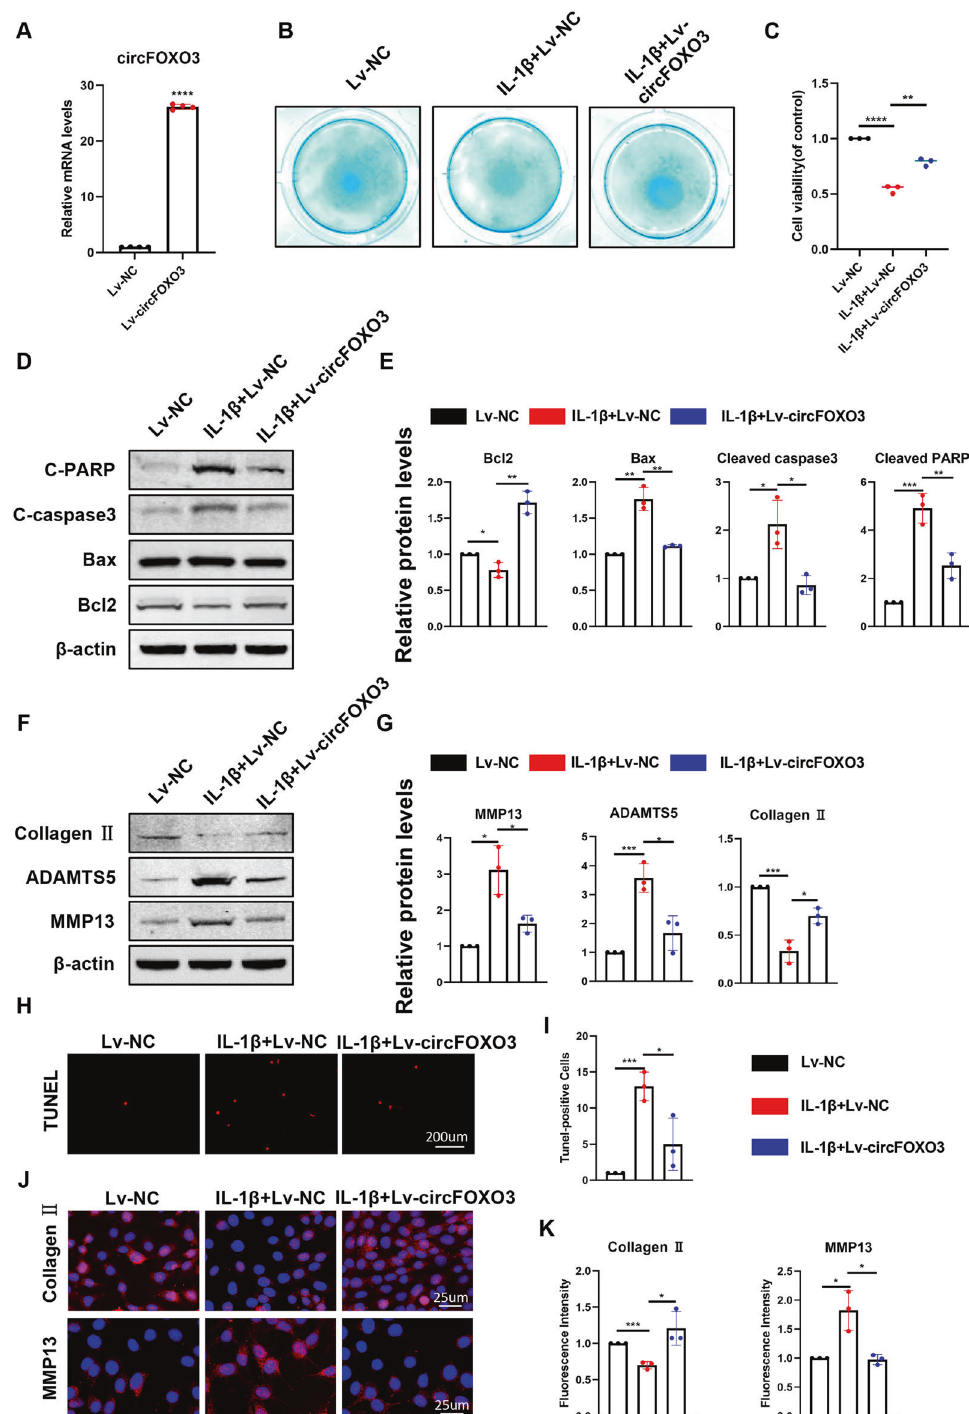
Fig. 3 Overexpression of circFOXO3 on cell viability, apoptosis and ECM metabolism in ATDC5 chondrocytes. A The overexpression ef fi ciency of circFOXO3 in ATDC5s detected by qRT-PCR. ( n = 4) **** p < 0.0001. B Alcian blue staining of lentivirus-treated ATDC5 chondrocytes. C Cell viability determined by CCK-8 assay. (n = 3) ** p < 0.01, **** p < 0.0001. D , E Western blot analysis of Cleaved PARP, Cleaved caspase-3, Bax and Bcl2 when circFOXO3 was upregulated in ATDC5 chondrocytes. The optical density analysis was performed from the results of three independent experiments of western blot samples. * p < 0.05, ** p < 0.01, *** p < 0.001. F , G Western blot analysis of MMP13, ADAMTS5 and Collagen II when circFOXO3 was upregulated in ATDC5 chondrocytes. The optical density analysis was performed from the results of three independent experiments of western blot samples. * p < 0.05, *** p < 0.001. H , I ATDC5s proliferation activity was detected by TUNEL staining when circFOXO3 was overexpressed. Representative photomicrographs and quantitative data showing the percentage of TUNEL-positive cells are shown. ( n = 3) Scale bar, 200 µm. * p < 0.05, *** p < 0.001. J , K Representative photomicrographs and fl uorescence intensity of IF of MMP13, and Collagen II in ATDC5s after treating with IL-1 β (10 ng/ml) for 24 h and the saving effects of overexpressed circFOXO3 on IL-1 β . ( n = 3) Scale bar, 25 µm. * p < 0.05, *** p < 0.001.